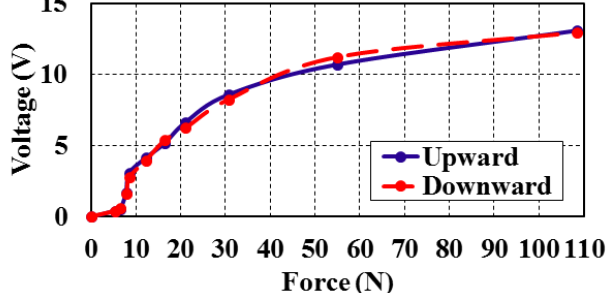
Figure 8. Output voltage from the sensor versus the applied force in upward and downward directions.